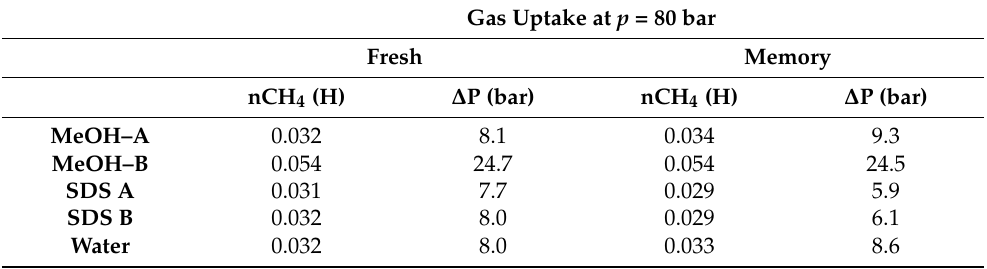
Table 3. Provides gas uptake (nCH 4 (H)) and total pressure drop (ΔP) in the presence of low dosage MeOH, SDS, and water during fresh and memory runs. Peq = 28.5 bar at 1 ◦ C for CH 4 gas hydrate. MeOH, SDS, and water during fresh and memory runs. Peq = 28.5 bar at 1 °C for CH 4 gas hydrate.